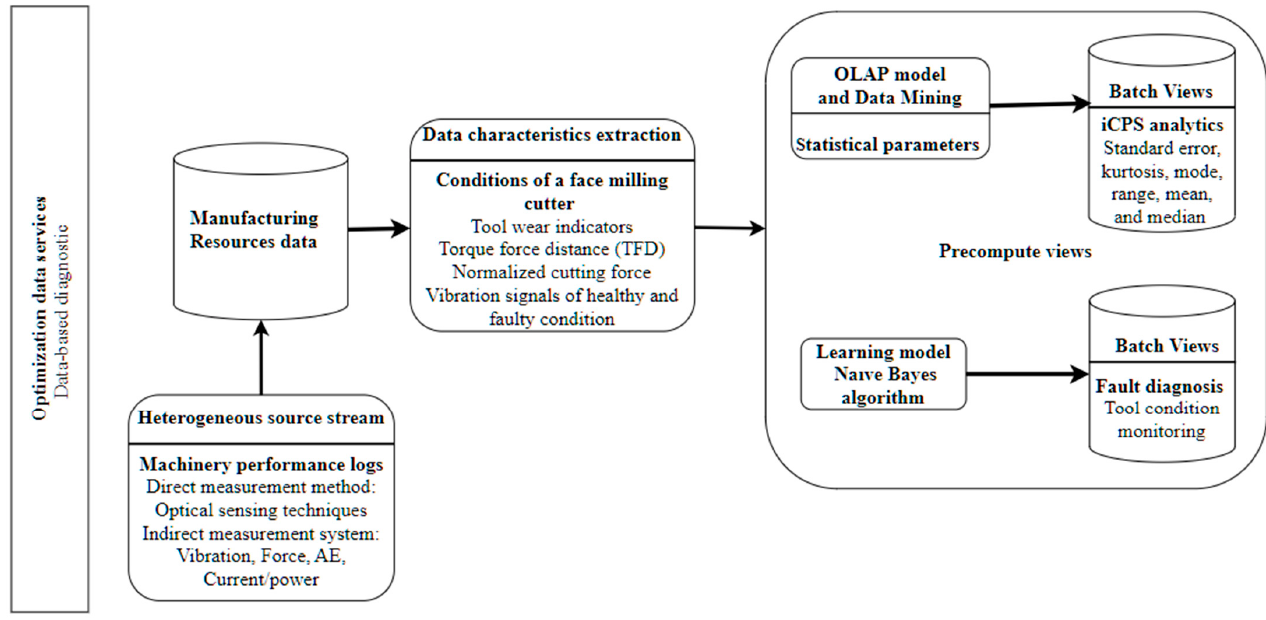
Figure 12. Instance of the fault diagnosis process.